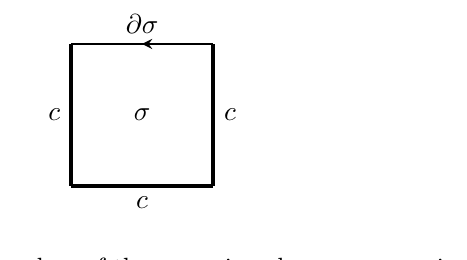
Figure 4 . Definition of ∂ : homotopy class of the map given by a square σ is mapped to the loop given by its upper